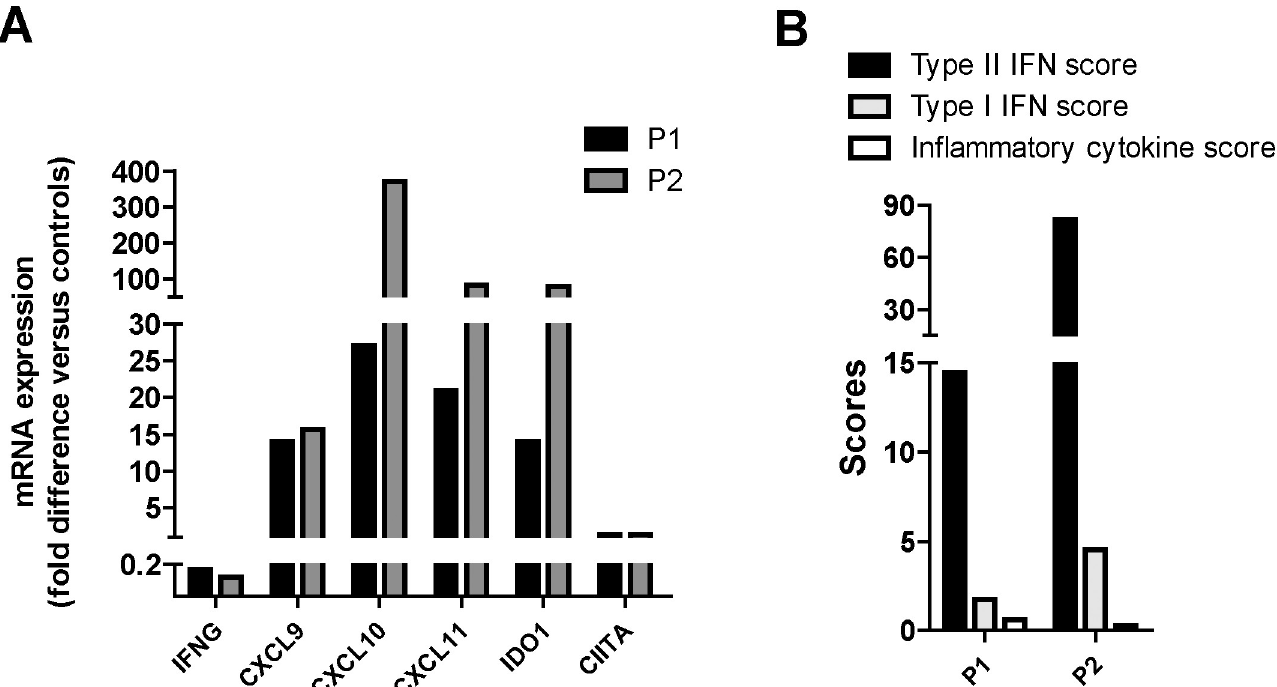
Fig 5. The IFN γ signature is up-regulated in PBMCs of P1 and P2 collected during the active phase of sHLH. A) mRNA expression levels of IFNG and IFN γ - inducible genes were evaluated in PBMCs collected from P1 and P2 at early stages of disease and compared to those observed in PBMCs collected from healthy controls (n = 3). Results are obtained after normalization with the housekeeping gene HPRT1 and are reported as fold difference versus the mean values obtained in controls. B) Type II IFN score, Type I IFN score and inflammatory cytokine score in PBMCs were calculated as reported in materials and